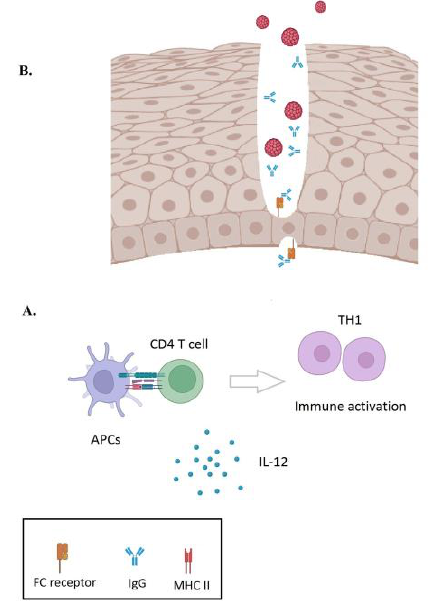
Figure 1. ( A )After HPV vaccination, the antigen-presenting cells (APCs) expose the L1 epitopes to CD4 + T cells through the major histocompatibility complex class II molecules (MHC-II). CD4 + T cells in turn secrete cytokines that activate B-cells, T-cells (TH1; T-Helper 1 cells) and macrophages. HPV vaccination generates prolonged IgG antibody titers. ( B ) The produced antibodies (IgG) traverse the epithelial layer through the neonatal Fc receptor that is expressed at the epithelial cells of the cervix. In addition, IgG can also be transferred directly at the site of injury in the basal epithelial cell layer in order to block viral infection.